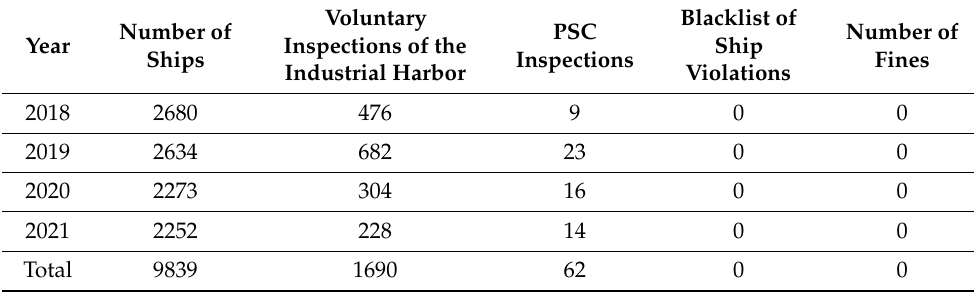
Figure 3. Flow chart of ballast water management into the Mailiao Industrial Harbor (Yes: Approve or agree; No: Reject or disagree). Table 1. Ship Inspection Statistics of Mailiao Industrial